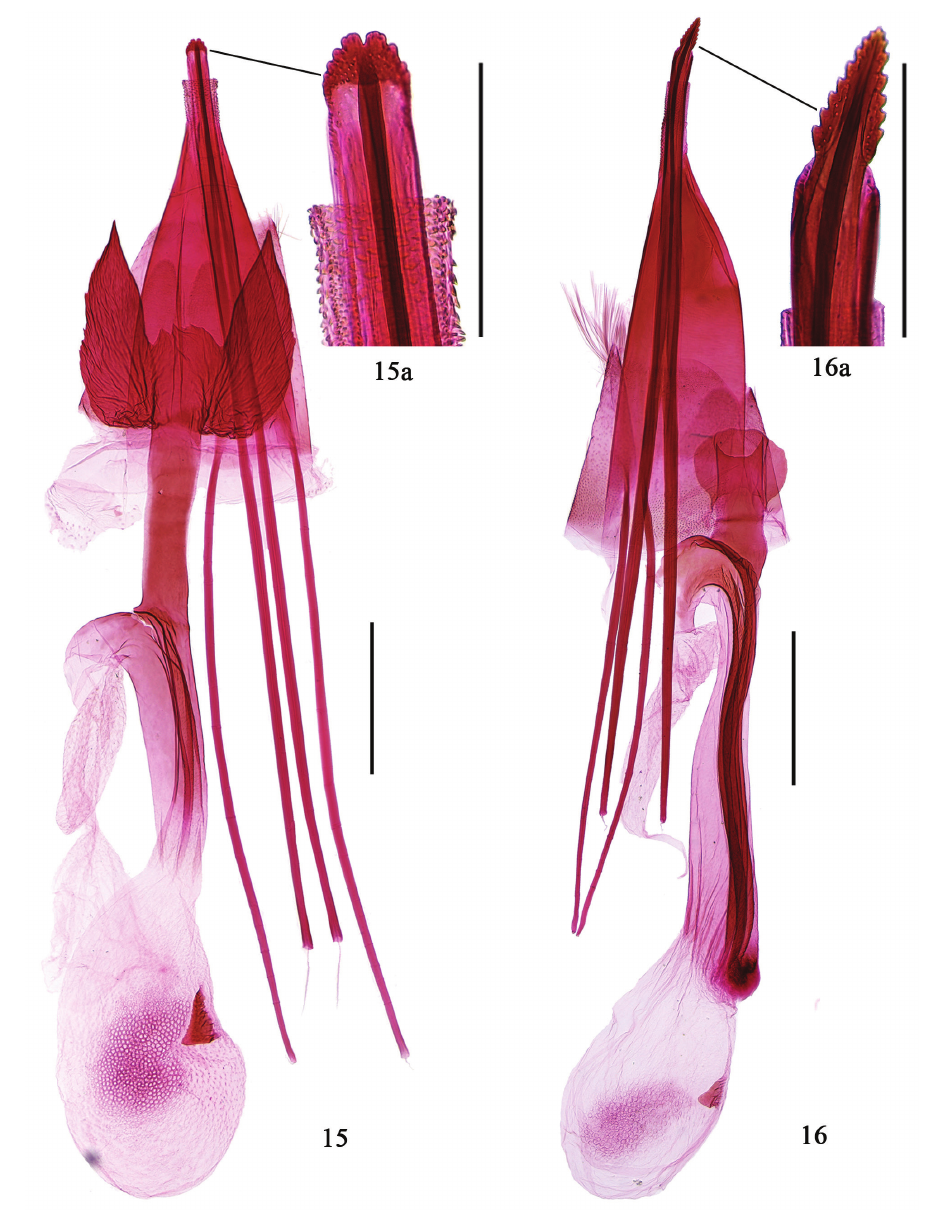
Figures 15–16. Female genitalia of Epicephala spp. 15 E. domina sp. n., paratype, genitalia slide No. WZB14295 16 E. impolliniferens sp. n., paratype, genitalia slide No. WZB14249. Scale bar: 0.5 mm ( 15, 16 ); 0.1 mm ( 15a, 16a